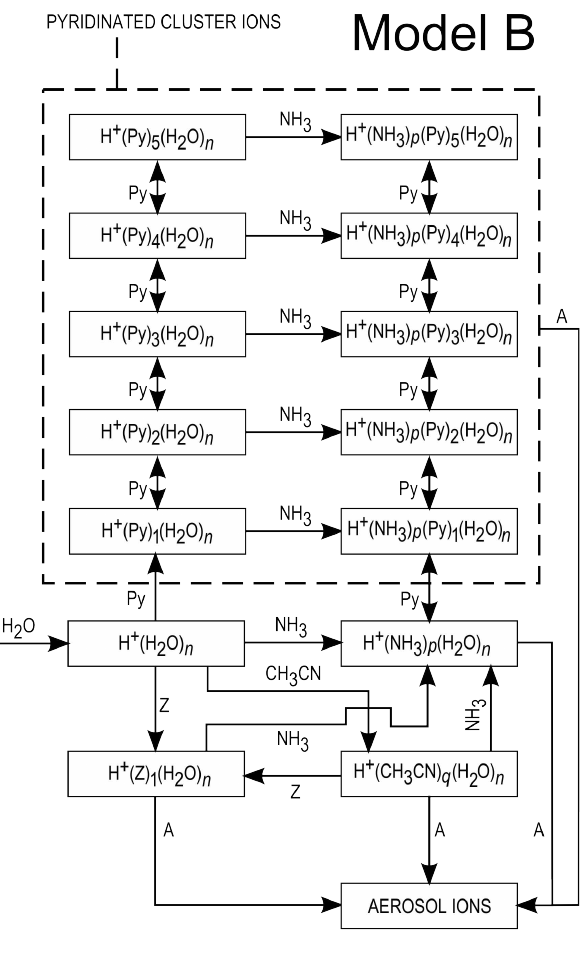
Fig. 2. Tropospheric cluster ion reaction scheme used in Model